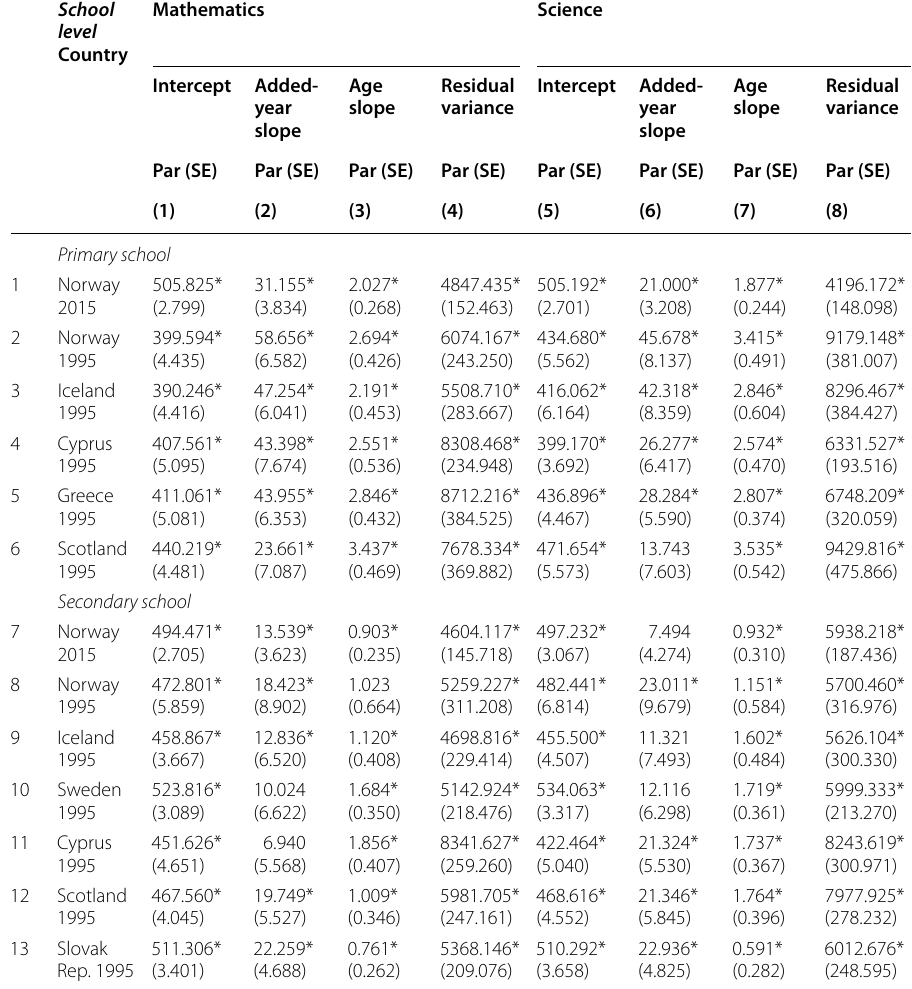
Table 10 Results of the regression discontinuity analyses with student-level